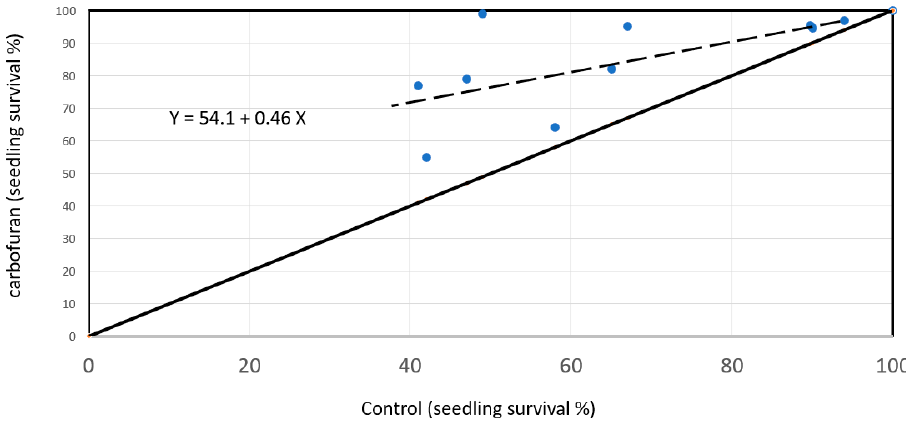
Figure 20. Treating seedlings with an effective soil-applied insecticide at the time of planting increased the survival of bareroot loblolly pine and slash pine. Data from [27,151,154]. Although carbofuran is no longer tested or sold in the USA, a rate of 1.8 g per seedling increased seedling survival. Carbofuran is banned in Canada and the EU, but it currently is used to control weevils in row crops in several countries. Points above the solid line represent sites where carbofuran increased survival. p > |t| = 0.004 for intercept and 0.052 for slope; R 2 = 0.39.